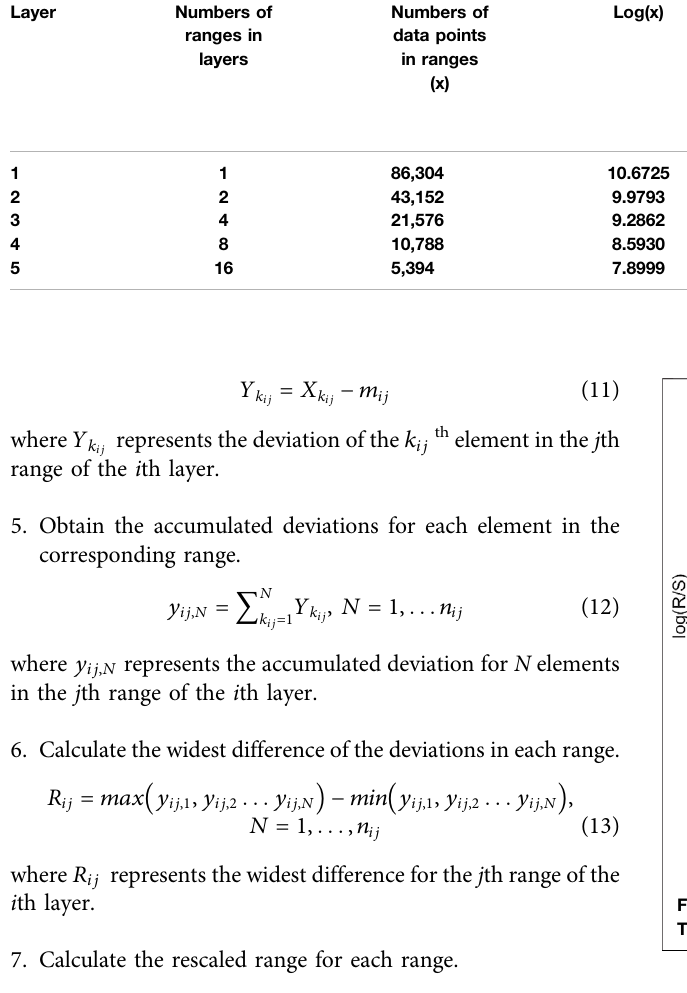
TABLE 1 | Some intermediate results of calculating the Hurst parameter of the foggy image in Figure 5A . Layer Numbers of ranges in layers